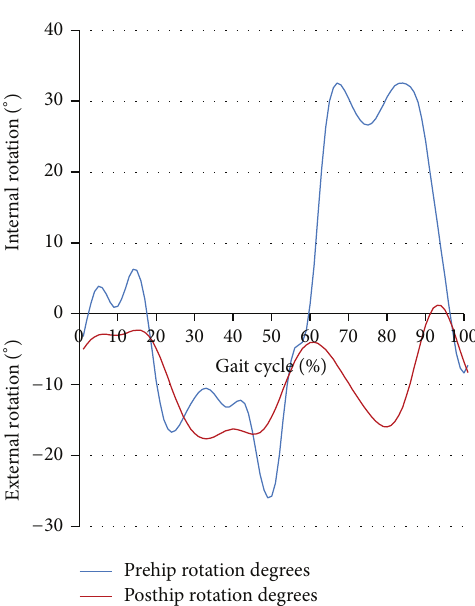
Figure 4: Hip joint kinematic